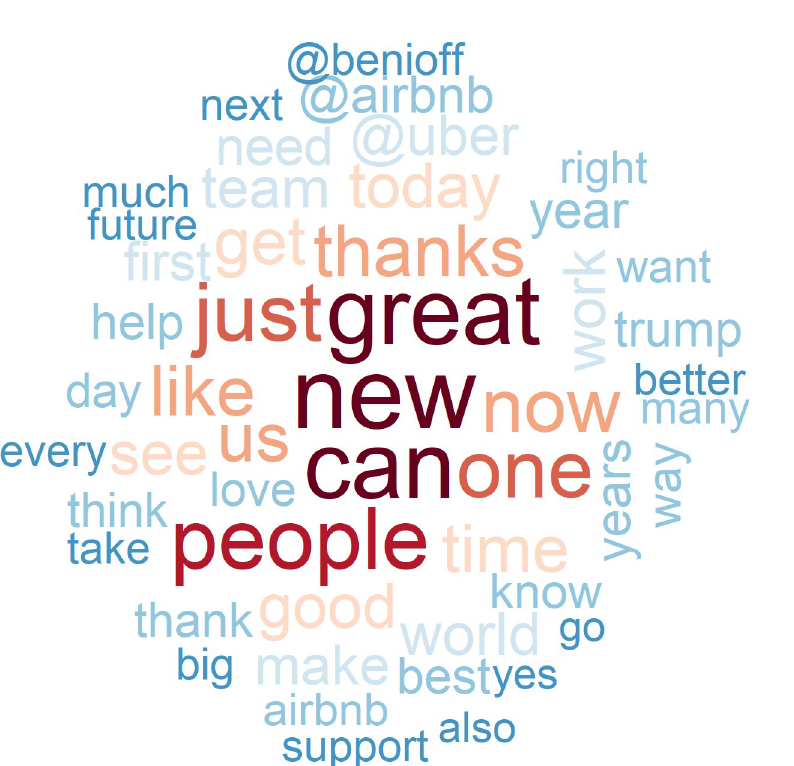
Fig 3. The 50 most often used words in tweets of the tech elite (N = 49,790).